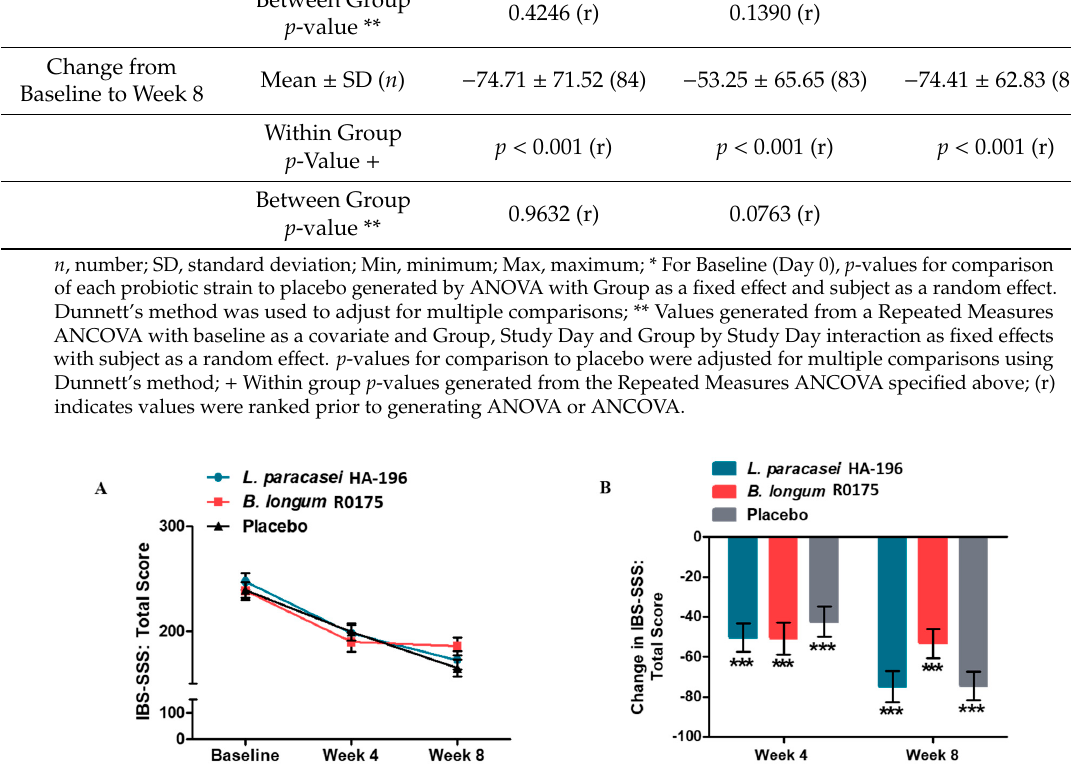
Figure 3. Effect of Lactobacillus paracasei HA-196 and Bifidobacterium longum R0175 on the IBS symptom severity score. ( A ) Mean Total IBS-SSS at baseline, week 4 and week 8; and ( B ) Mean change in IBS-SSS from baseline to week 4 and week 8 for participants in the PP population. L. paracasei group n =